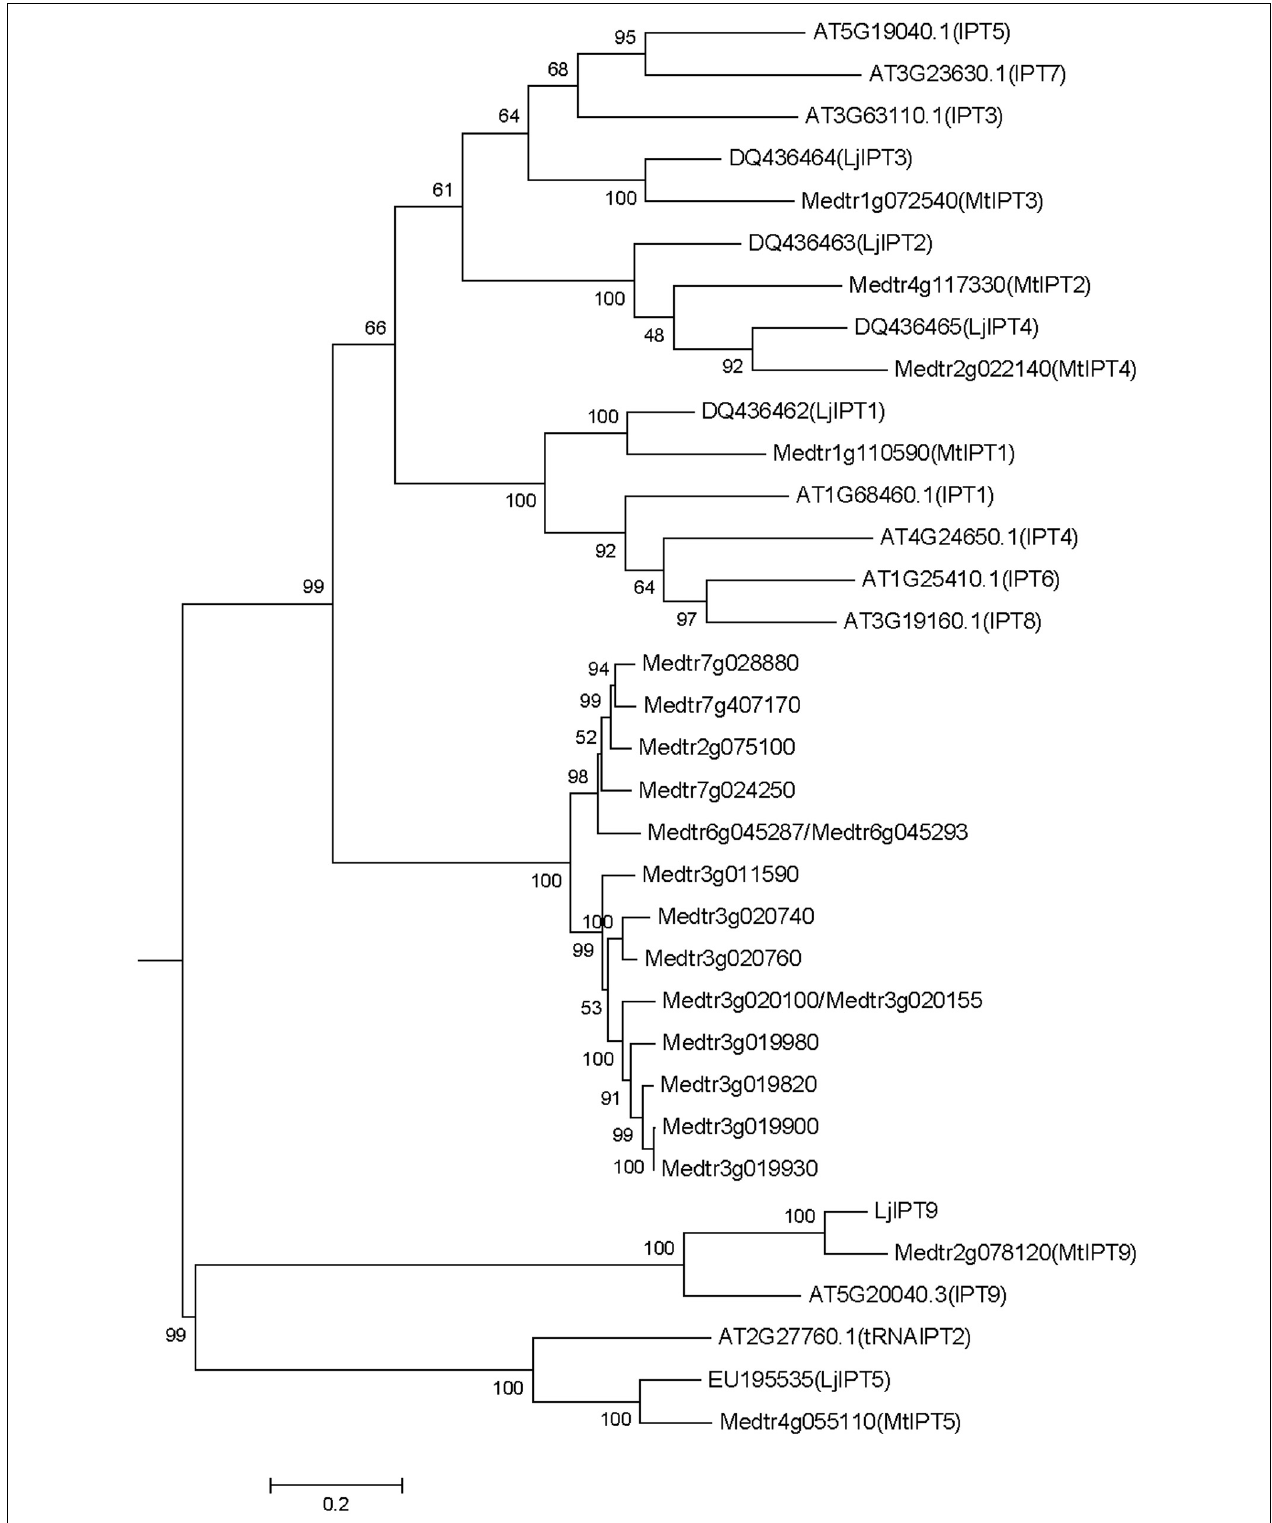
FIGURE 1 | Phylogenetic tree for Medicago truncatula , Arabidopsis thaliana, and Lotus japonicas IPT genes constructed based on their nucleotide sequences. Tree was obtained using Maximum likelihood algorithm with 1000 bootstrap replicates. Medicago and Arabidopsis gene (locus) IDs and Lotus Genbank accession numbers are indicated on the